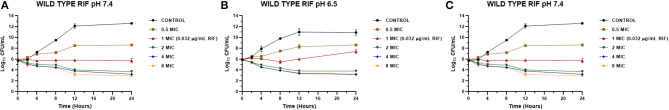
Time-kill curve for rifaximin on Staphylococcus aureus wild types (n = 3, using the mean of triplicates for each strain) at pH 7.4 (A), 6.5 (B), and 5.0 (C) [minimum inhibitory concentration (MIC) = 0.032 μg/mL].